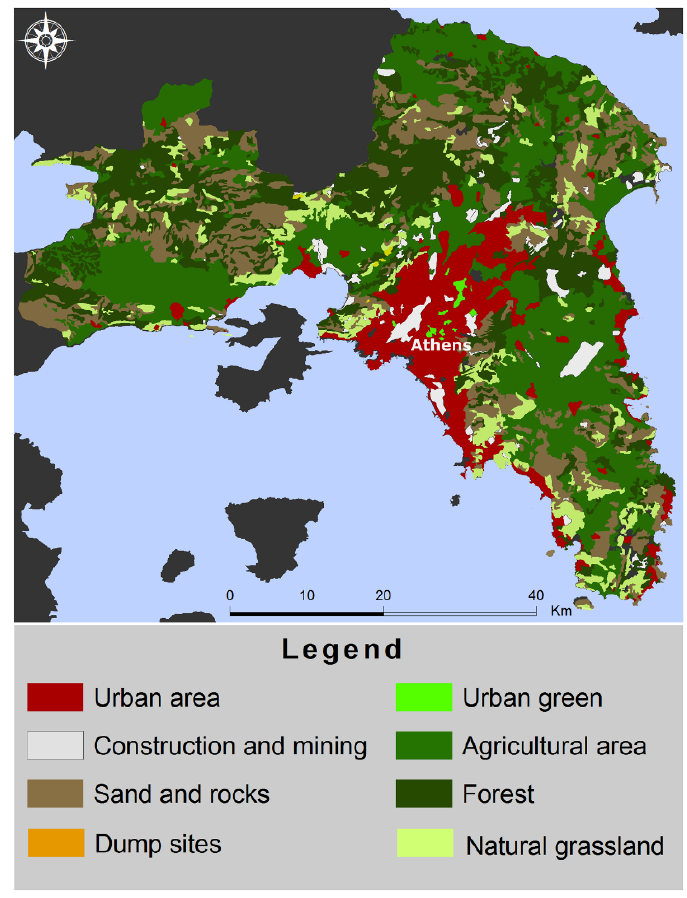
Figure 2. Polygons that represent the land cover according to the specifications of the project Corine Land Cover Greece 2000, funded by E.U., derived from LANDSAT TM.